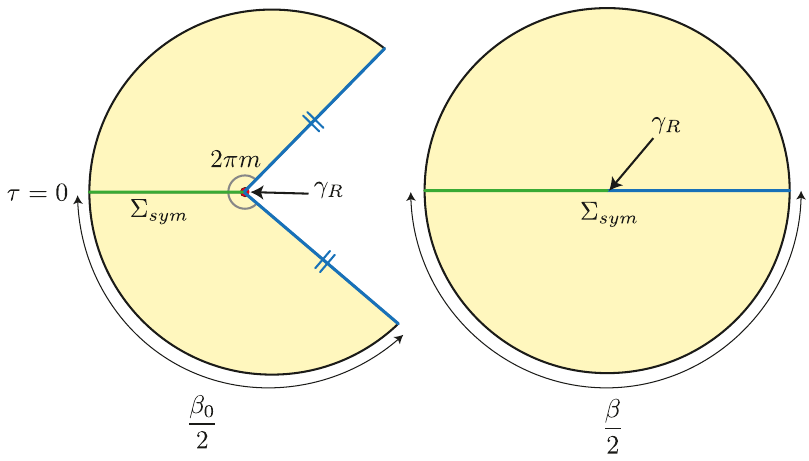
Figure 1 . Left: starting from a TFD state with inverse temperature β 0 , fixing the area of the HRT surface γ R , corresponding to the time slice τ = 0 , results in a Euclidean saddle with a conical singularity (red) with opening angle 2 πm , where m = β 0 . Right: the same state prepared as a β microcanonical TFD state by imposing asymptotic fixed energy boundary conditions. This results in a smooth Euclidean saddle with boundary length β . The Z 2 symmetric Cauchy slice Σ sym (green and blue) on both saddles has identical data and thus, results in identical Lorentzian spacetimes upon time